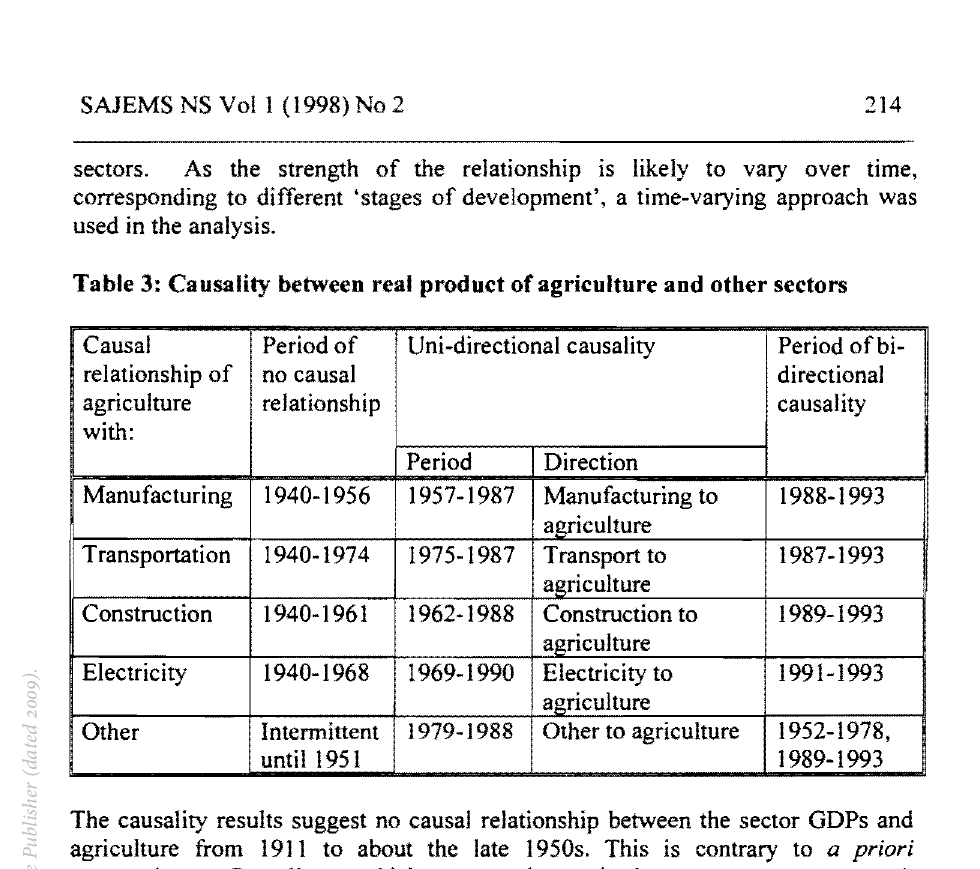
Table 3: Causality between real product of agriculture and other sectors Causal Period